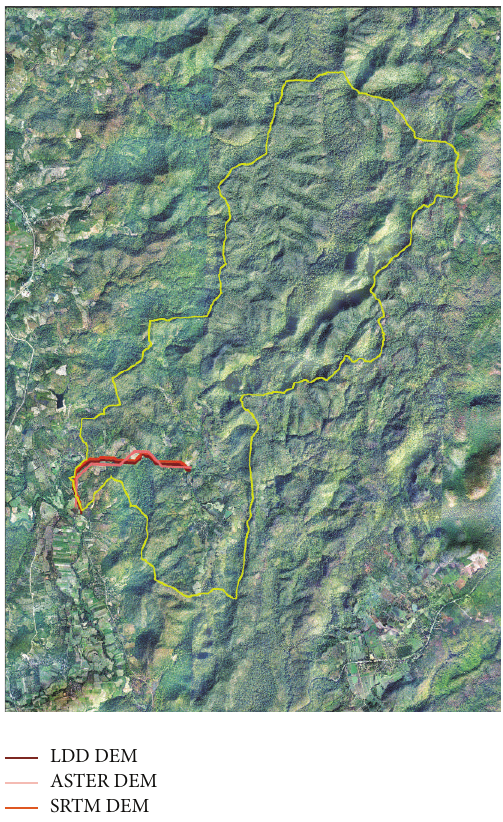
Figure 6: Stream lengths extracted from DEMs of Huai-Sai-Khaw watershed.